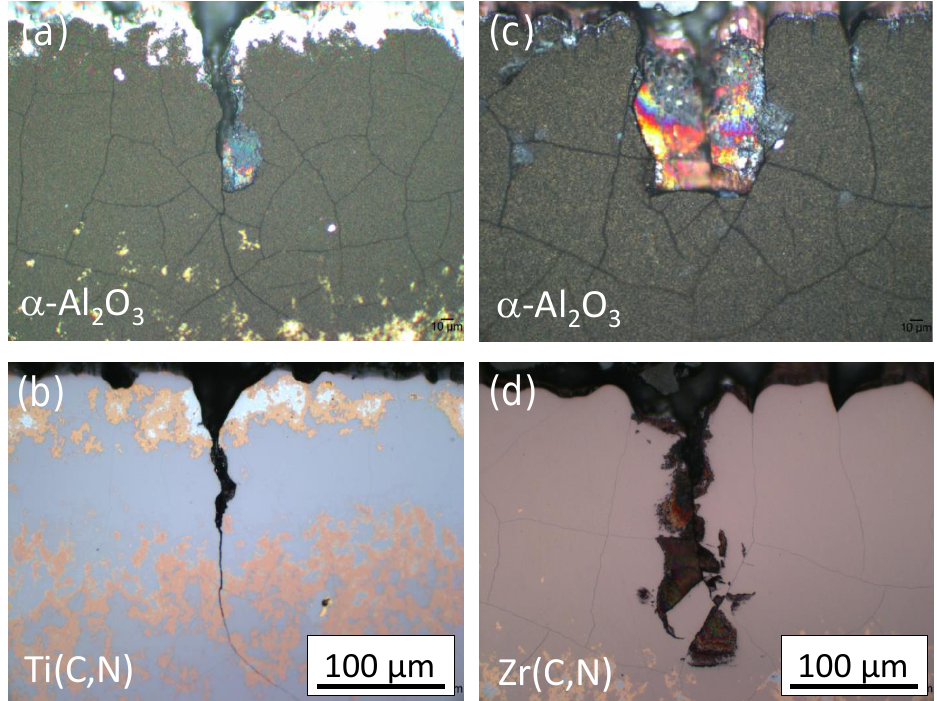
Figure 8. Comb crack morphology revealed after sequential polishing of the cutting edge for Ti(C,N)/ α -Al 2 O 3 ( a , b ) and Zr(C,N)/ α -Al 2 O 3 ( c , d ) systems. Comb cracks propagate on existing CVD cooling crack network. The morphology of the cracks differs for the Ti(C,N) ( b ) and the Zr(C,N) (d)—based systems.